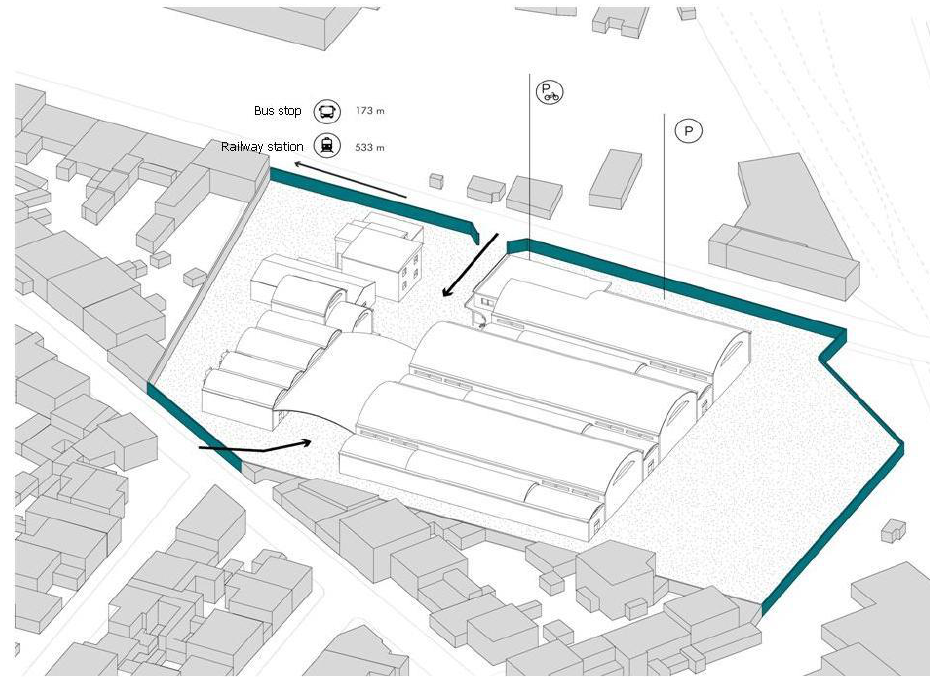
Figure 3. New urban relationships (in green the wall to be demolished).